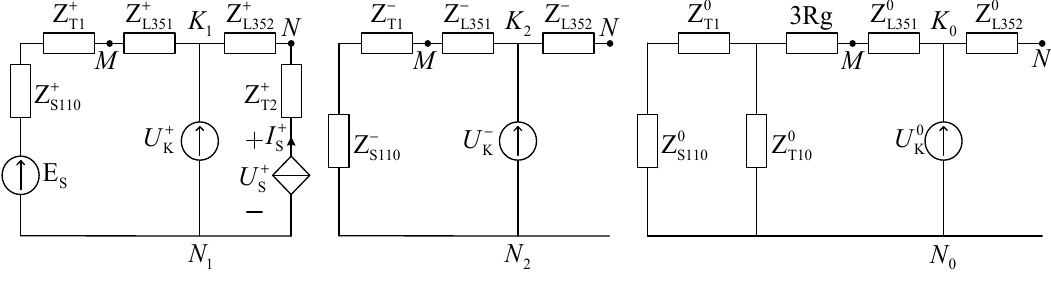
Figure 2. The equivalent circuit diagram with the fault on the tie-line.